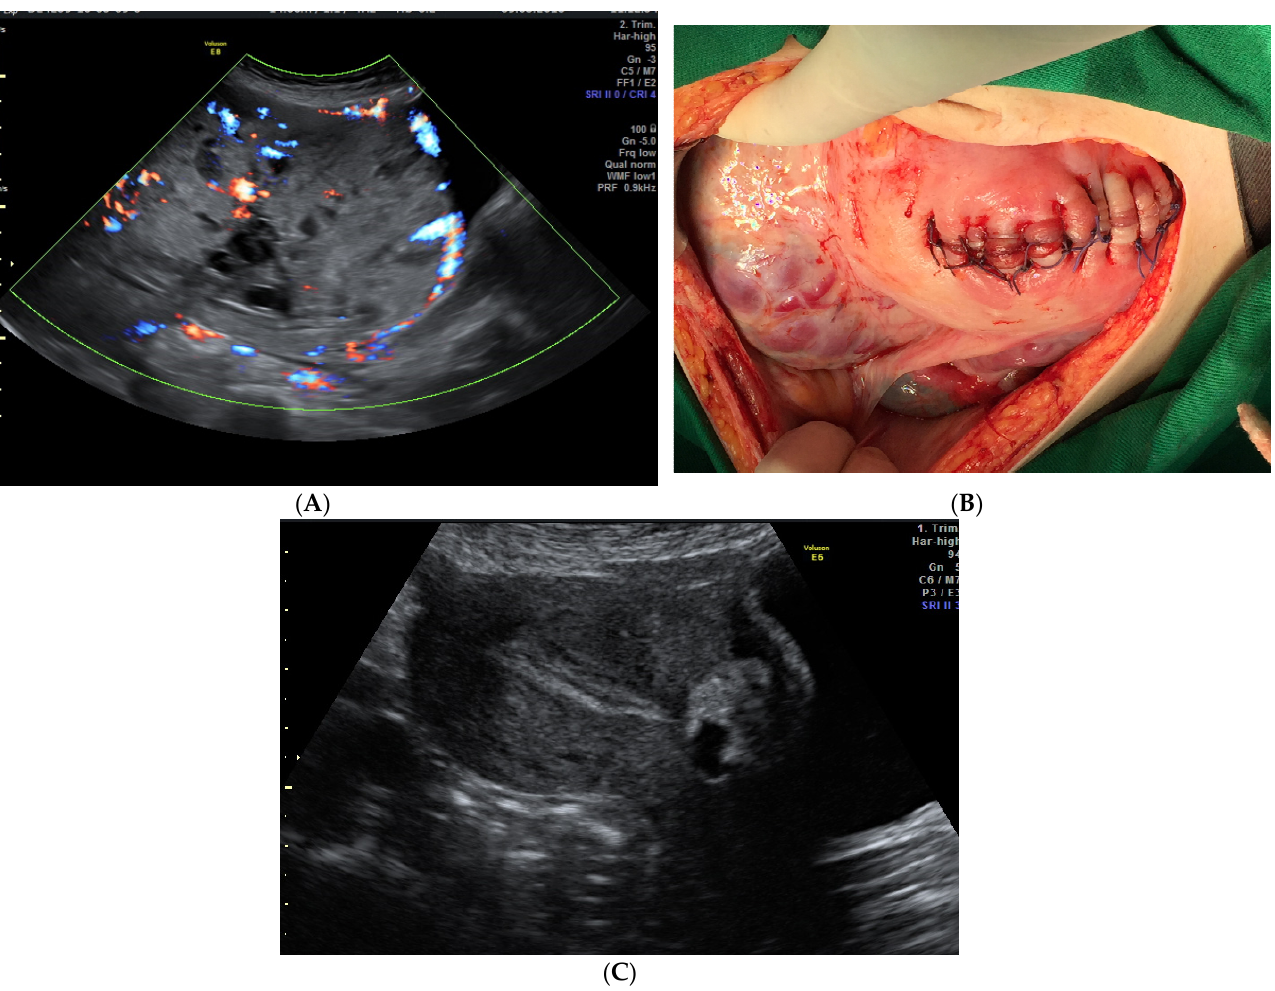
Figure 1. ( A ). Ultrasound appearance of the placenta at 35 weeks of pregnancy. ( B ). Placenta left in situ and corporeal-fundal uterine suture at delivery. ( C ). Transabdominal ultrasound examination 27 weeks after delivery. On the anterior uterine wall, the small placenta is noted, and the endometrium is linear. The patient had a history of CS and, at 20 weeks, she was diagnosed with placenta previa with a high suspicion of anterior abnormal invasion to the urinary bladder. She had no vaginal bleeding. Planned Caesarean section was performed at 36 weeks of gestation, with a vertical midline incision chosen for the abdomen and a fundal incision of the uterus to avoid the upper pole of the placenta. After the delivery of the baby, the decision to leave the placenta in situ was taken to avoid significant bleeding and bladder injury. After the ligature of the umbilical cord close to its placental insertion, the uterine wall was sutured ( B ). Close monitoring was offered and, at 27 weeks after delivery, the placenta was almost fully evacuated ( C ) and the patient had normal menstruation. The treatment options for PAS and their advantages and disadvantages are presented in Table 2. Table 2. Analysis of different management decisions in PAS disorders. Advantages